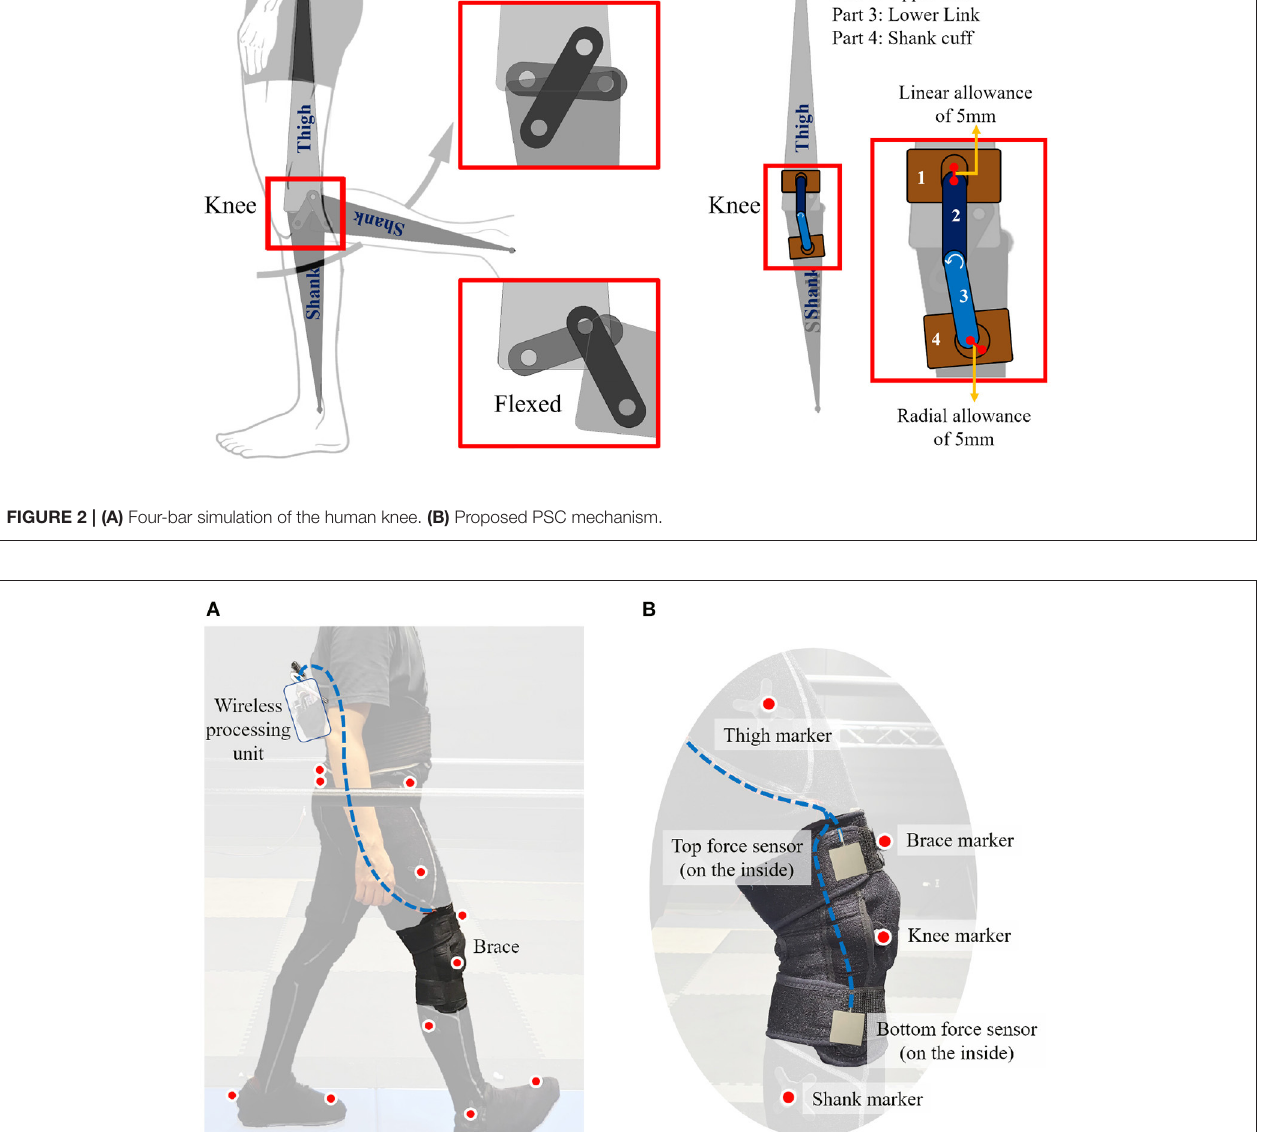
measured forces. While measuring forces, participants were The order of the constrained braces (i.e., SA, PPC, and PSC) asked to stand erect and still. This procedure standardized that followed was randomized. During the first constrained the tightness of fit across all constrained braces. Note that brace trial, the tightness of fit was measured using the force the forces were not measured for the Control brace because the sensors. The force readings at the bottom and top force absence of a constraining mechanism always resulted in a lower sensors were referred to as f 0 and f 0 . The constrained top bottom force braces that followed were then fitted to within ± 1 N of said